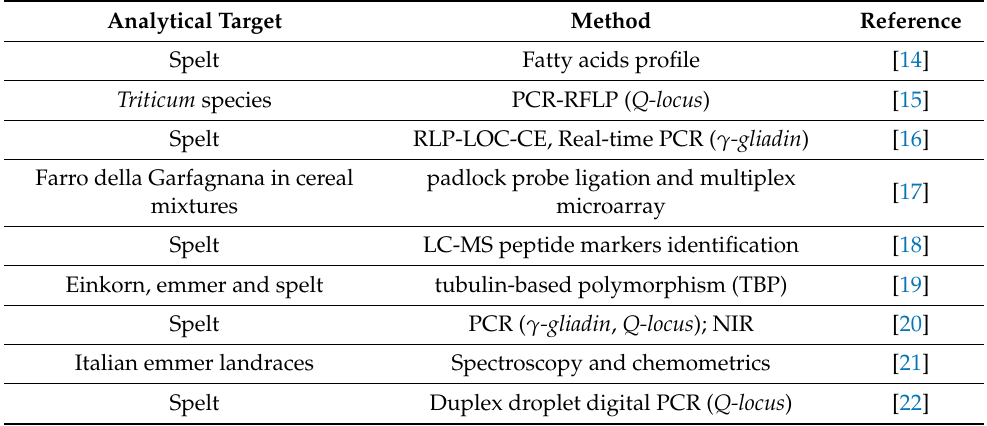
Table 1. Analytical assays proposed for the identification and quantification of hulled